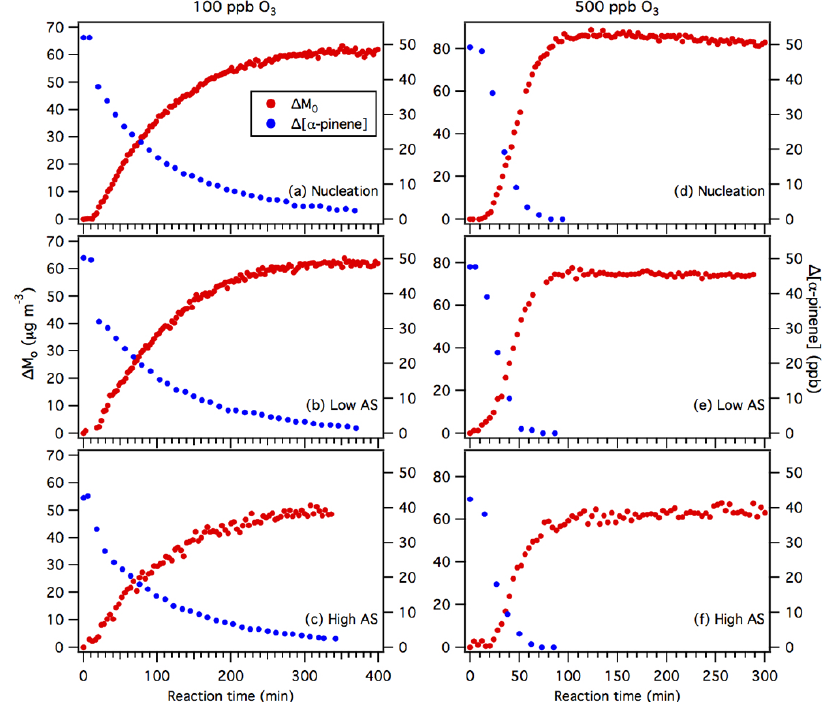
Figure 2. Reaction profiles of the α -pinene ozonolysis experiments. Panels (a, b, c) show results from the nucleation, low-AS and high- AS 100ppb O 3 experiments, respectively. Panels (d, e, f) show results from the nucleation, low-AS and high-AS 500ppb O 3 experiments, respectively. As explained in the main text, the SOA mass concentrations ( (cid:49)M o ) for the nucleation and low-AS experiments are obtained using the particle wall deposition rates obtained from the low AS-seed-only experiments, while the SOA mass concentrations ( (cid:49)M o ) for the high-AS-seed experiments are obtained using the particle wall deposition rates obtained from the high AS-seed-only experiments.